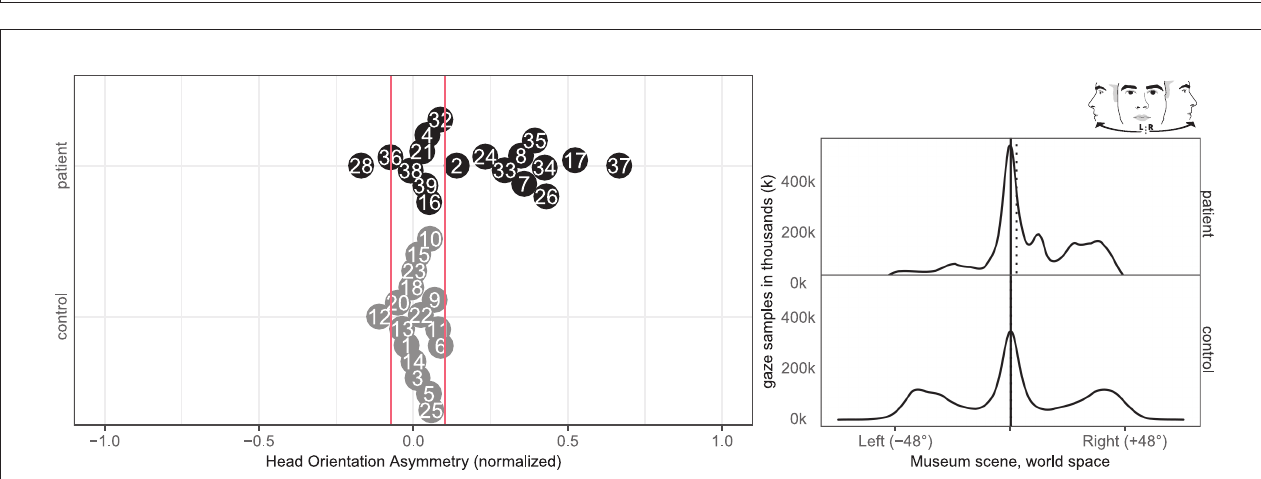
Frontiers in Psychology |